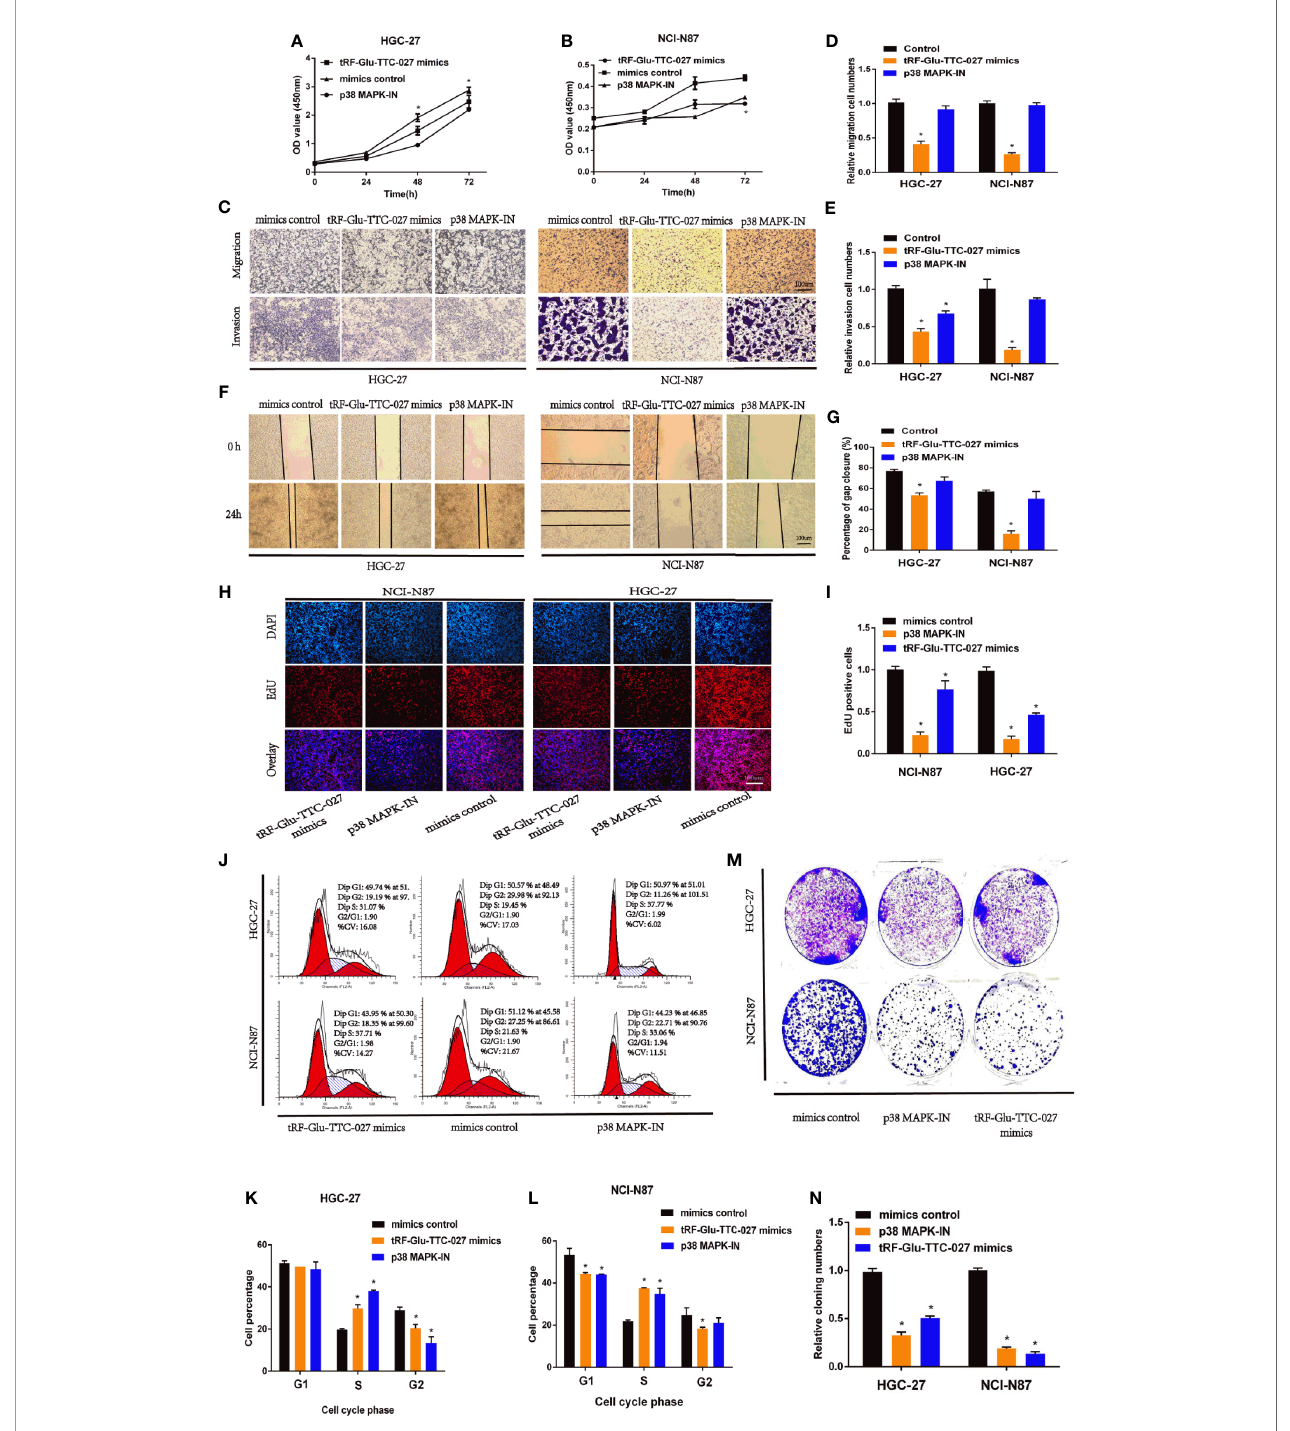
FIGURE 4 | tRF-Glu-TTC-027 declined the biological function of gastric cancer in vitro . (A, B) The CCK-8 assay indicated that tRF-Glu-TTC-027 and p38 MAPK pathway inhibitor (p38 MAPK-IN) could effectively decline the proliferation of NCI-N87 and HGC-27. (C – E) tRF-Glu-TTC-027 was capable of suppressing the migration and invasion capacities of NCI-N87 and HGC-27 cell lines. (F, G) Through the observation and calculation of the cell gap closure, we demonstrated that tRF-Glu-TTC-027 was capable of fully inhibiting the migration ability of GC cells in the wound healing assays. (H, I) EdU assays showed that tRF-Glu-TTC-027 and p38 MAPK-IN formed fewer DNA replication levels than the control group. (J – L) The impact of tRF-Glu-TTC-027 and p38 MAPK-IN on GC cell cycle pro fi le using fl ow cytometry. (M, N) The obvious change in the number of cell clones in the colony formation assays fully con fi rmed the inhibitory effect of tRF-Glu-TTC-027 and p38 MAPK-IN on GC. (*P < 0.05, Student ’ s t-test. Scale bar = 100